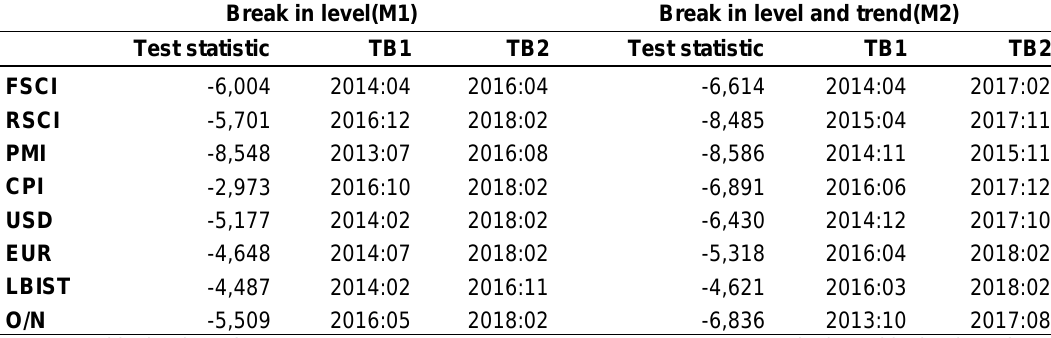
Table 3. Narayan and Popp (2010) ADF unit root test results with two structural breaks. Break in level(M1) Break in level and trend(M2) Test statistic TB1 TB2 Test statistic TB1 TB2